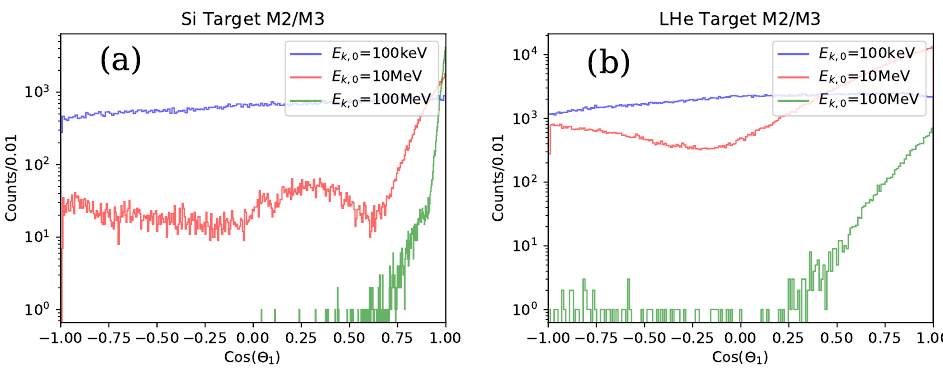
Figure 10. The distribution of cos ( Θ 1 ) for ( a ) silicon target, ( b ) liquid helium target.